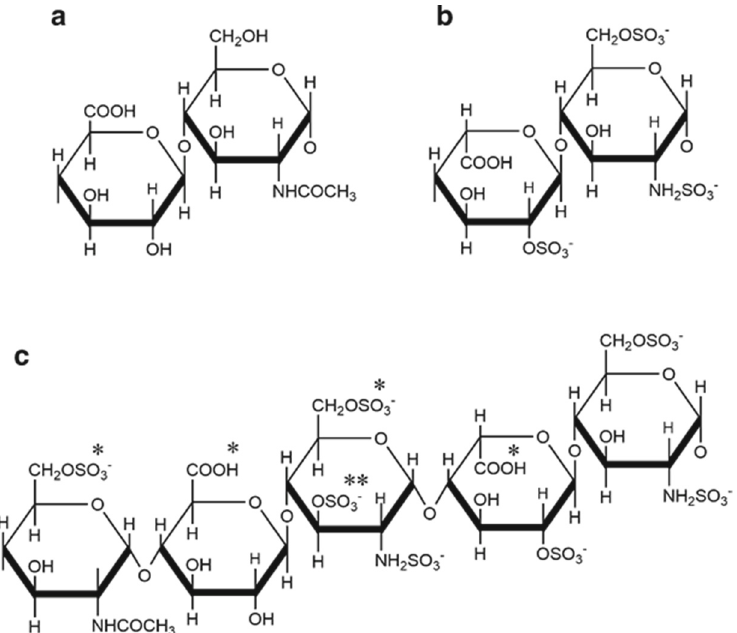
Figure 1. The main repeating disaccharide units found in the glycosaminoglycans heparan sulphate ( a ) and heparin ( b ). The polymers are composed of alternating hexuronate ( β - D -glucuronate in HS ( a ) and α -L-iduronate in heparin ( b )) and α - D -glucosamine residues, which are regularly 2-N and 6- O sulphated in heparin, joined by (1,4) glycosidic linkages. The anti-thrombin III high affinity binding pentasaccharide sequence found in pig mucosal heparin ( c ) contains essential substituents (*) and the unusual 3- O -sulphate substituent (**)Reprinted from ref. [1] (h tt p://creativecom-mons.org/licenses/by/4.0/).